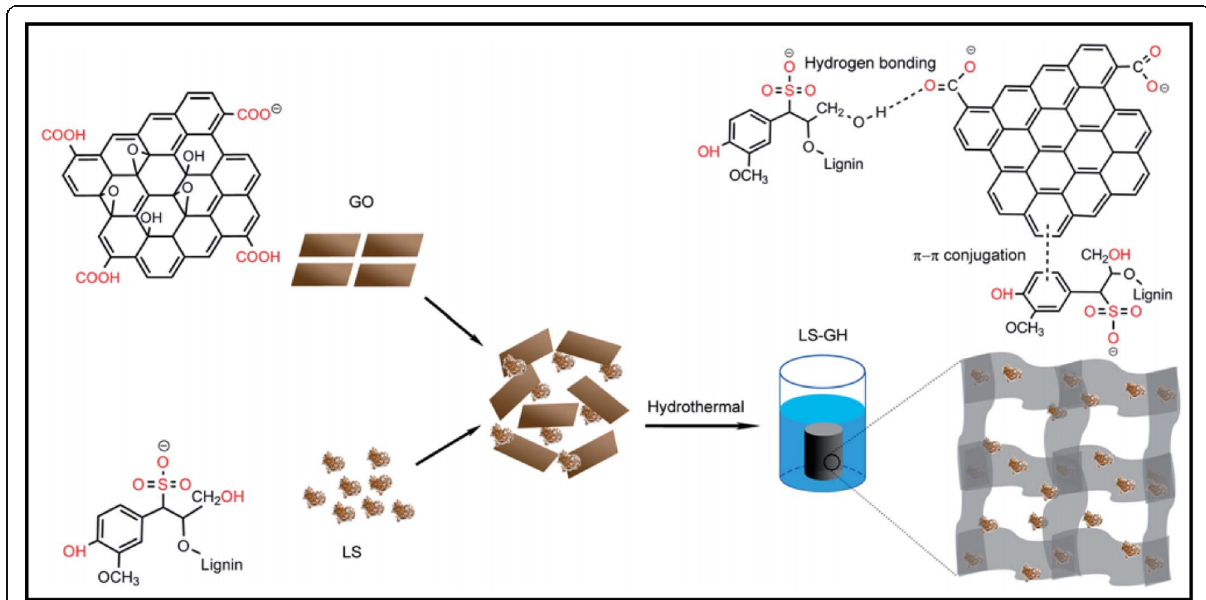
Fig. 6 The schematic of the one-step self-assembled of GO and LS for lignin-based biosorbent preparation. Reprinted with permission from ref.